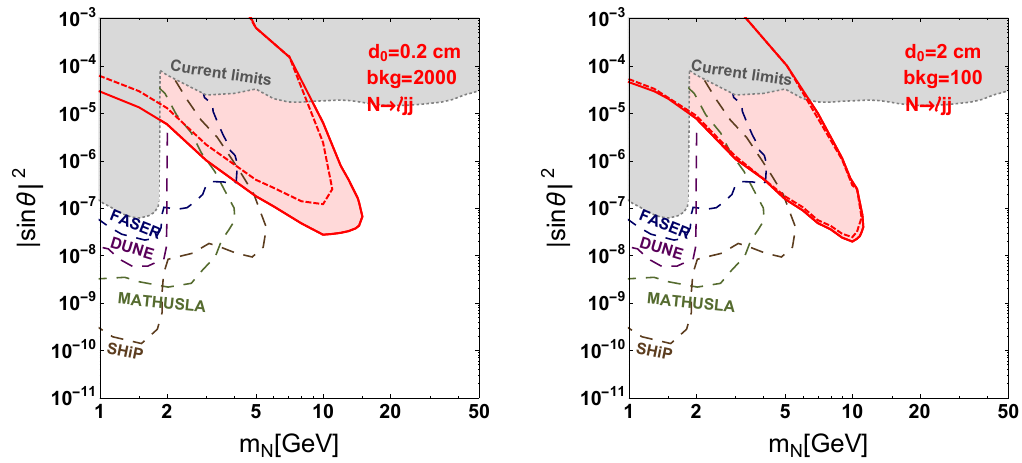
Figure 6 . The 95% C.L. reach for sterile neutrino from W gauge boson decay is plotted in the m N -sin 2 (cid:18) plane with solid red lines. The dashed red lines have included 10% systematic uncertainty e(cid:11)ect. The existing constraints are from CMS [81] and DELPHI [82] for mass larger than 1 GeV. While for mass smaller than 2 GeV, the stronger constraints are from beam dump experiments like NuTeV [34], CHARM [28, 32], BEBC [29], and FMMF [33]. The existing current limits are shaded in gray color and labeled as \Current limits". The proposed sensitivity reaches for MATHUSLA [53], FASER [52], DUNE [37] and SHiP [38, 84] are shown in dashed